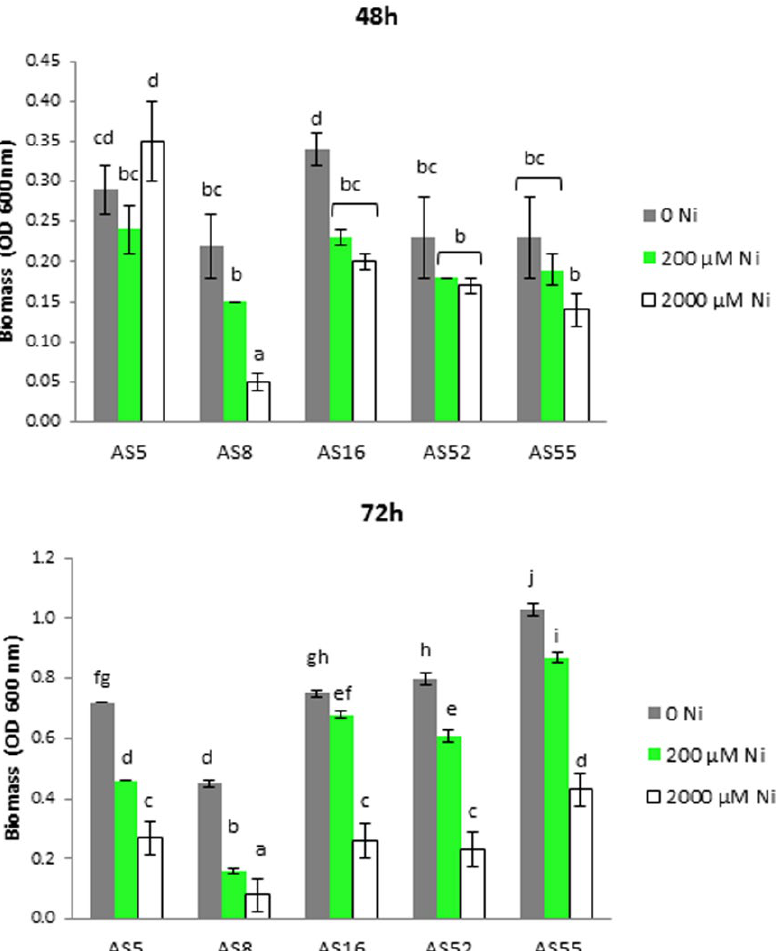
Figure 1. Growth in terms of absorbance at 600 nm (optical density at 600 nm, OD 600) A. vulneraria rhizobial isolates supplemented with different concentrations of Ni. Different letters indicate a statistically significant difference among treatments in ANOVA comparisons and the post-hoc Tukey HSD at p = 0.05. Error bars represent ± SD.